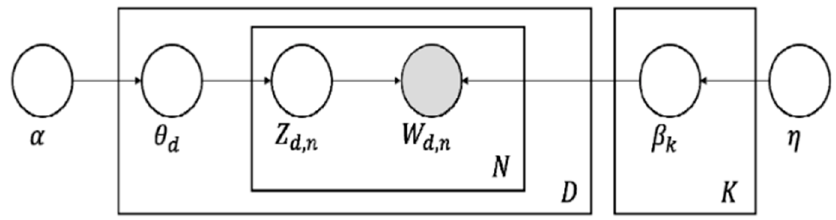
Figure 2. Graphical representation of LDA model.